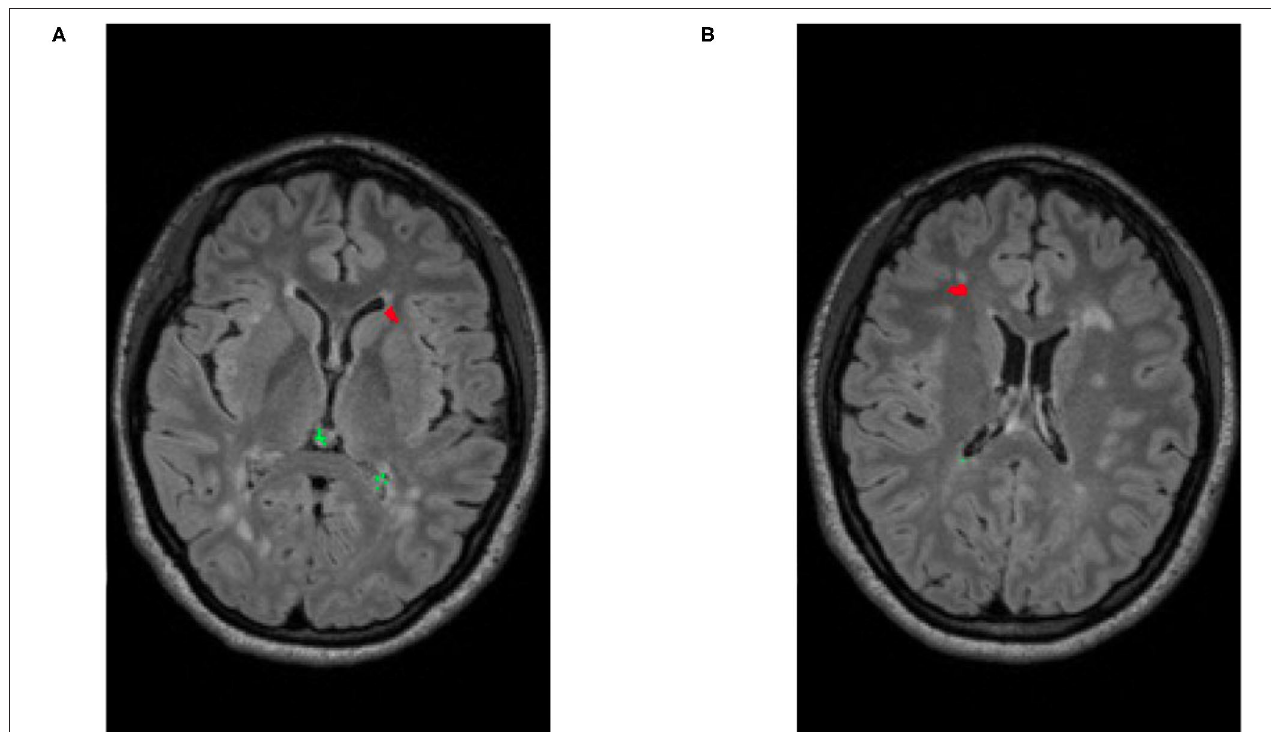
FIGURE 4 | Illustrative examples of detecting false positives and new lesions. (A) An example of patient with two identified false positives (depicted in green) and a new lesion (depicted in red). (B) Example of a different patient with a single identified false positive (green) and a single new lesion